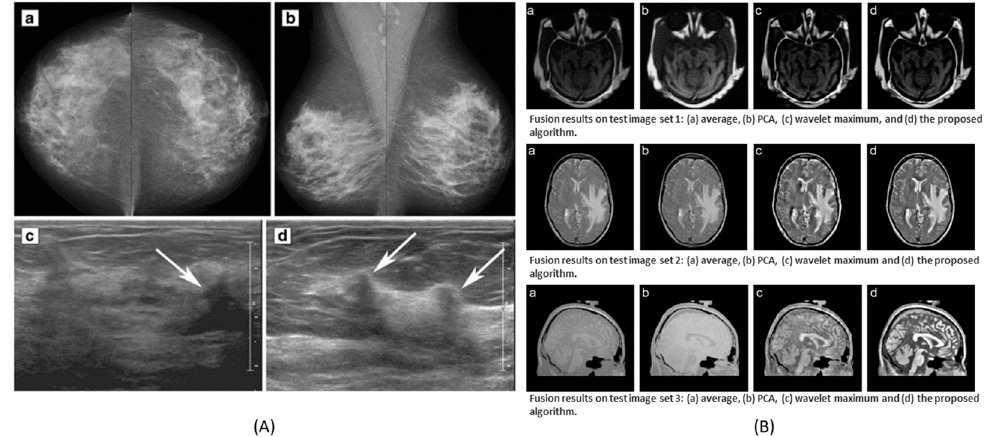
Figure 6. Data fusion as a result of different types of images. ( A ) Ultrasound and mammogram image fusion to detect breast cancer. ( B ) CT and MRI image fusion to provide high spatial quality of anatomical information and functional details of the diseases. ( A ) is reprinted with permissions from reference [36]. ( B ) is adapted with permissions from reference [37], 2008, Elsevier.